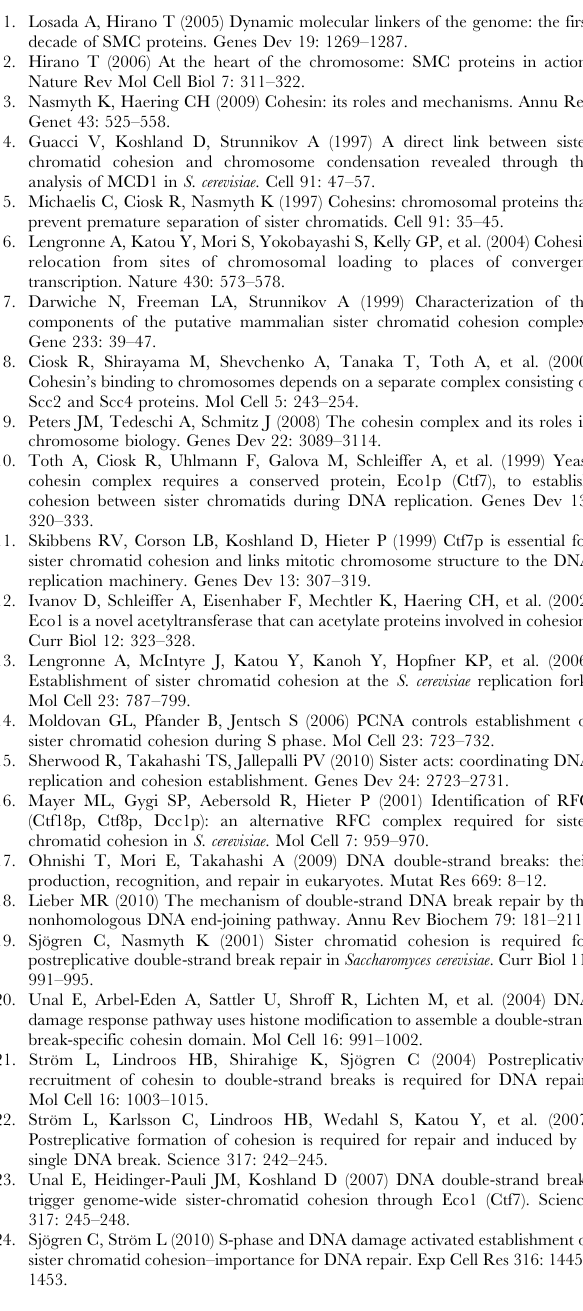
is shown below the WB panels at the different time points. (B) Quantification of A. Table S1 Genetic modifications of the yeast strains used in this study. All strains used were originally haploid and of W303 origin ( ade2-1, trp1-1, can1-100, leu2-3, 112, his3-11, 15, ura3-1, RAD5, GAL, psi + )